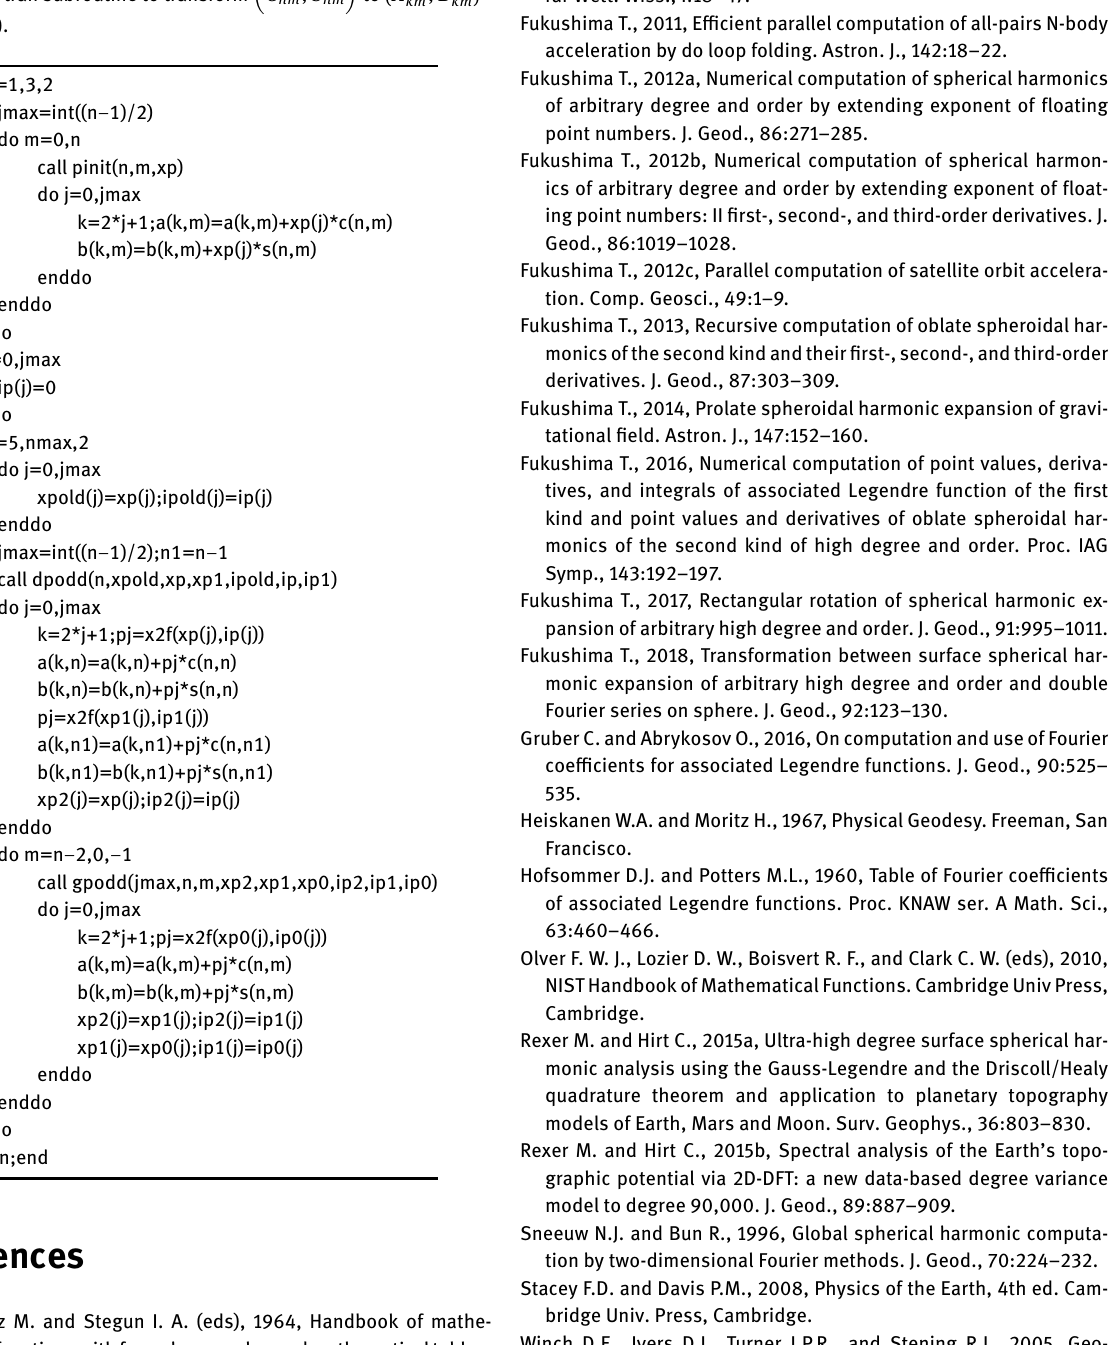
Table 9: Fortran subroutine to transform